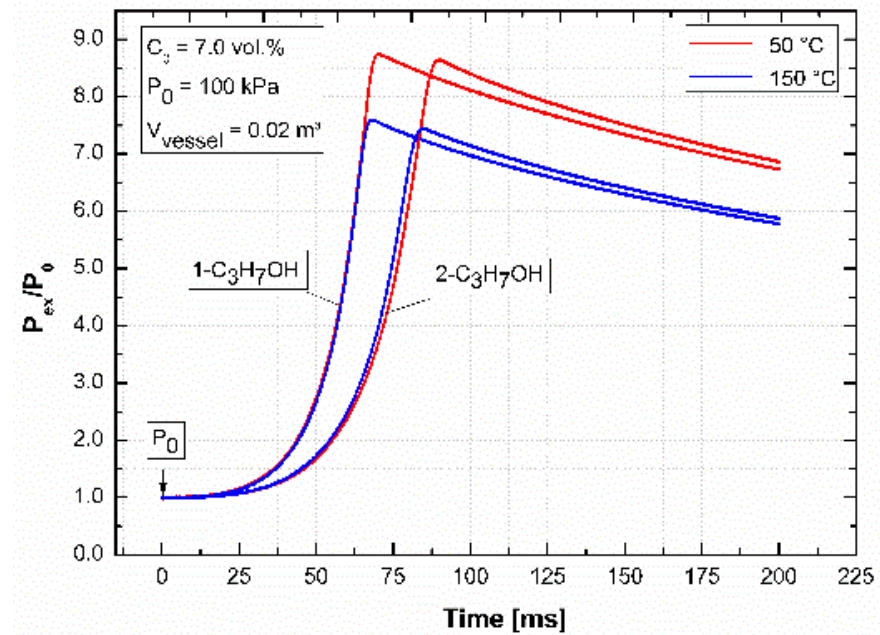
Figure 4. p ex /p 0 /time for 1-propanol and 2-propanol deflagration in a 0.02 m 3 vessel, p 0 = 100 kPa.